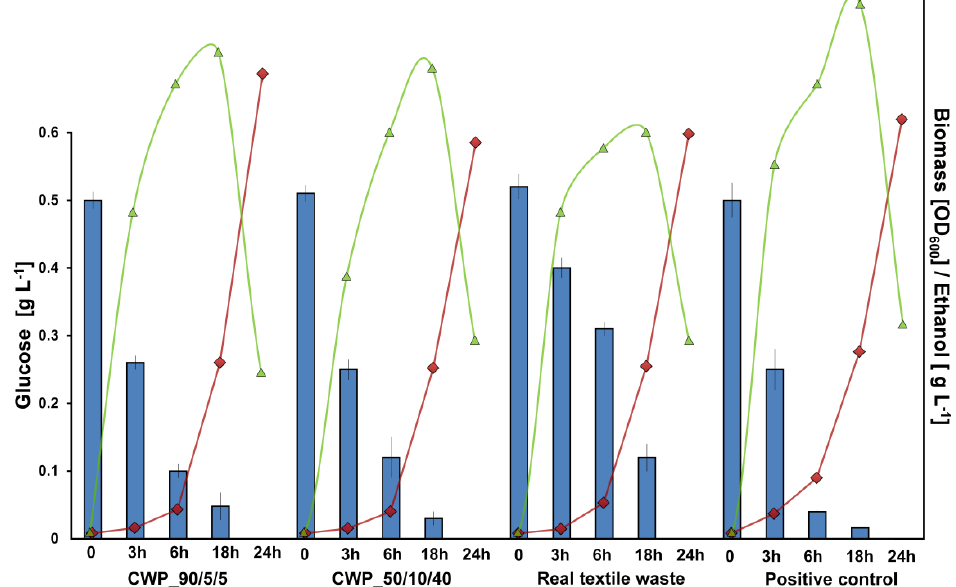
Figure 5. Fermentation of S. cerevisiae with the enzymatically recovered glucose. Time points collected after time 0, 3, 6 and 24 hours of incubation of yeast. The concentration of glucose (blue bars) and ethanol (green line) were quantified via HPLC analysis (experiments performed in triplicate). Biomass (red line) was quantified via spectrophotometric measurement of OD600.